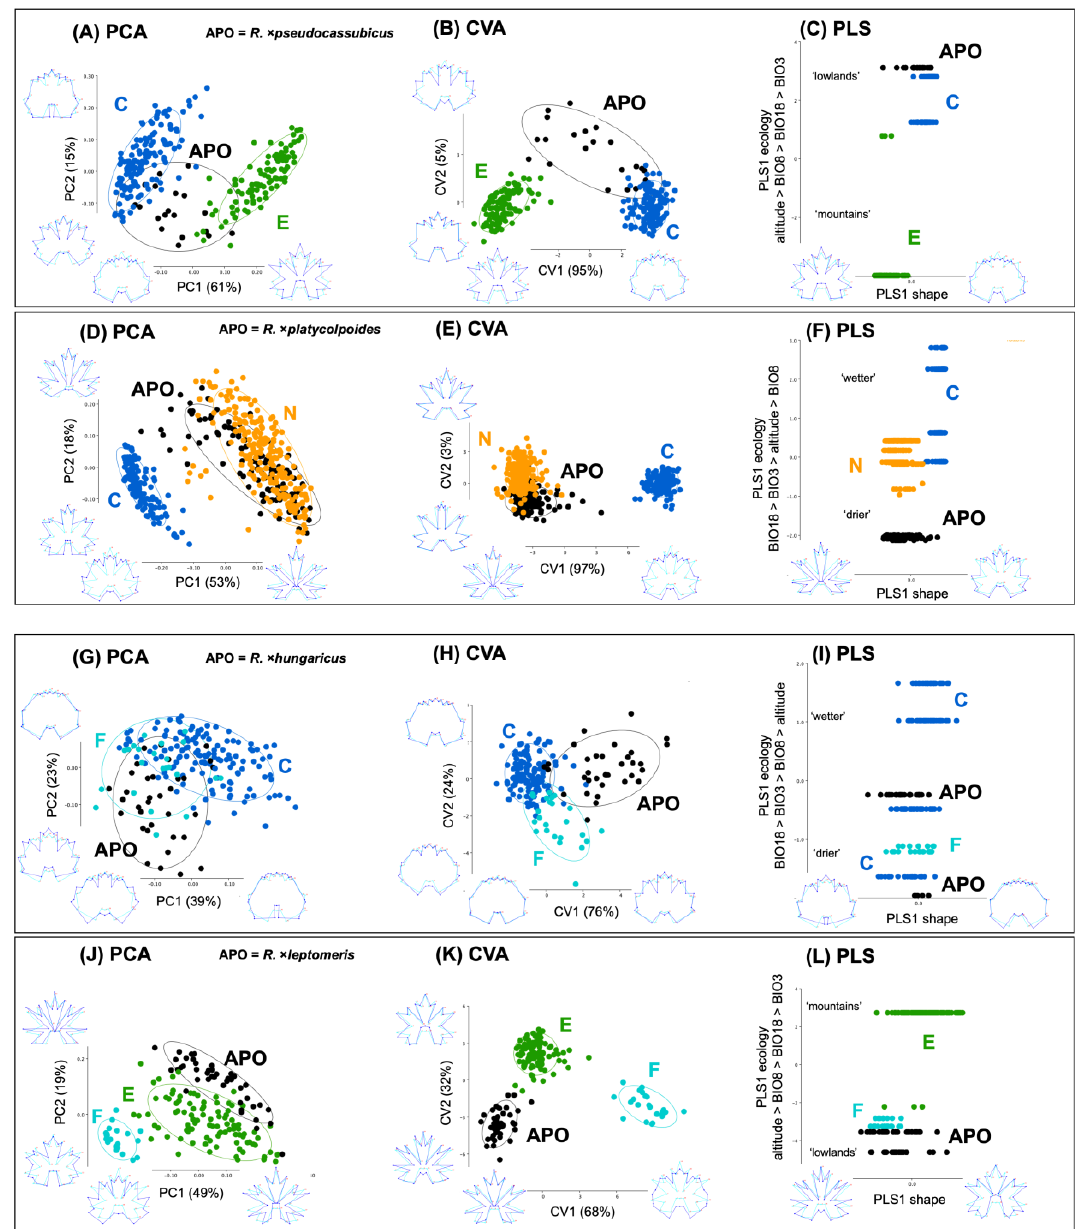
Figure 9. BL variation of sexual species and their selected allopolyploid apomictic (APO) derivatives. ( A – C ) R. × pseudocassubicus ; ( D – F ) R. × platycolpoides ; ( G – J ) R. × hungaricus ; ( K , L ) R. × leptomeris . PCA, principal component analyses, CVA, canonical variate analyses; PLS, partial least square anal- yses, ( A ) PCA of R. × pseudocassubicus (black dots) and two sexual progenitor species R. cassubicifolius (blue dots) and R. envalirensis (green dots). ( B ) CVA of the taxa in (A). ( C ) PLS of the taxa in (A). The first PLS axis described 99.6% of the covariance between BL shapes and the four ecological variables, and the covariance model had p < 0.001. The first ordination axis from the shape data (PLS1 shape) was significantly correlated (0.90; p < 0.001) with the first ordination axis from the ecological data (PLS1 ecology). The highest contribution to the ecological component was provided by altitude (- 0.79). ( D ) PCA of R. × platycolpoides (black dots) and two sexual species, R. cassubicifolius (blue dots) and R. notabilis (orange dots). ( E ) CVA of the taxa in (D); ( F ) PLS of the taxa in (D). The first PLS axis described 97% of the covariance between BL shapes and the four ecological variables, and the co- variance model had p < 0.001. The first ordination axis from the shape data (PLS1 shape) was signif- icantly correlated (0.63; p < 0.001) with the first ordination axis from the ecological data (PLS1 ecol- ogy). The highest contribution to the ecological component was provided by the precipitation of the